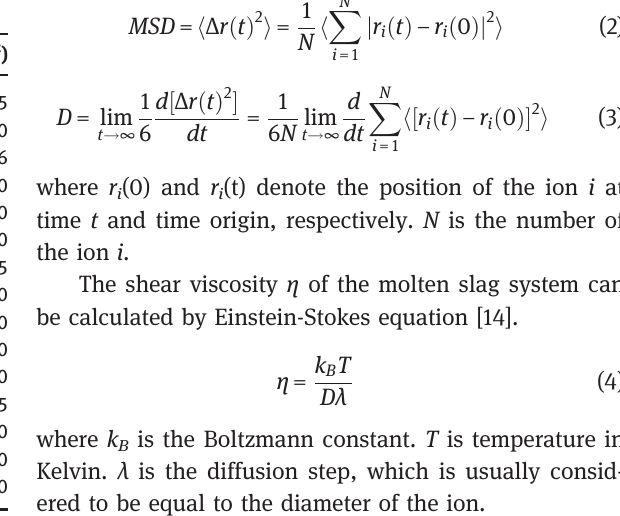
Table 1: Potential parameters used in computation.